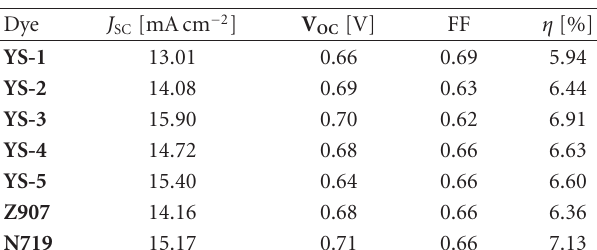
Table 1: Performance parameters of the YS-1–YS-5 dyes in DSSCs (taken from